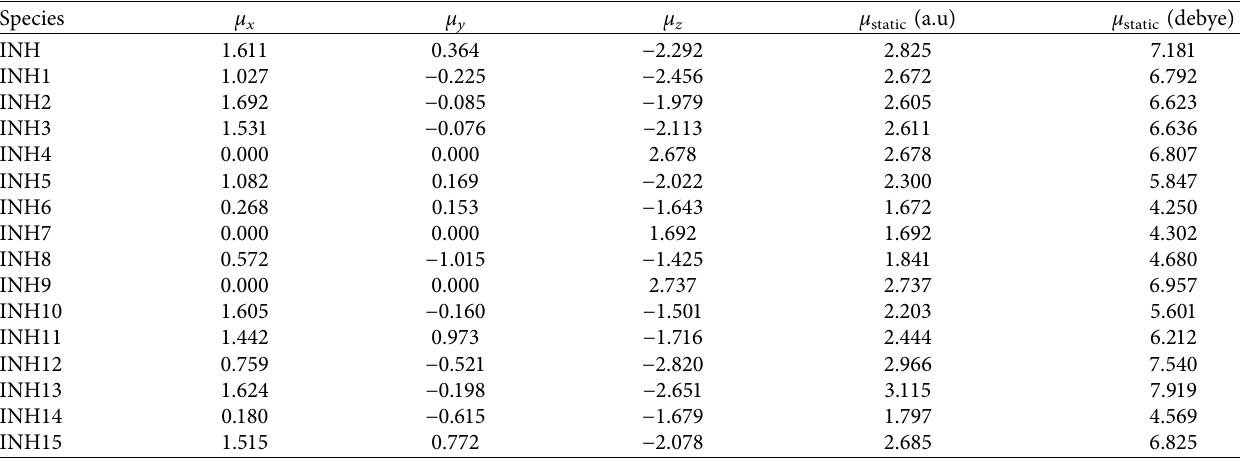
Table 5: Te static electric dipole moment ( μ ) of the studied compounds, calculated at ω � 0 at B3LYP-D/6-311G (d,p) level of theory in the gaseous phase.